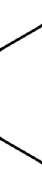
Figure 10. Graphene structure with 𝑙 = 1, 𝑘 = 1 .